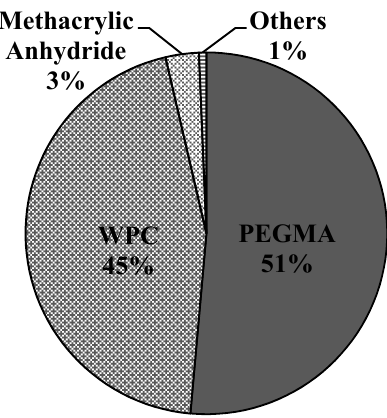
Figure 2. Annual materials costs contribution.